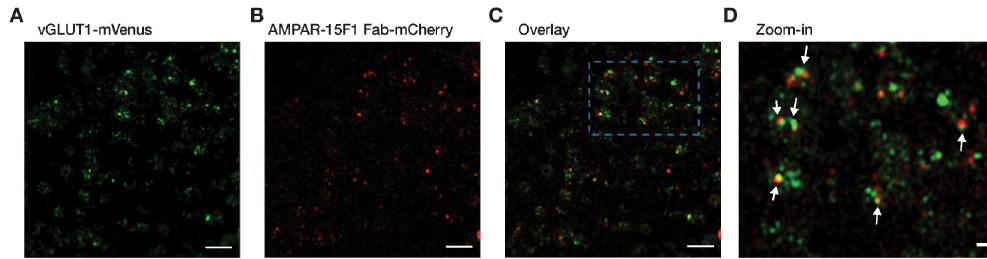
Fig 4. Cryo-LSM images of glutamatergic synaptosomes on cryo-EM grids passed through 1 μ m filter using a thermobarrel extruder. Fluorescence signals from green, red and both green & red channels corresponding to (A) vGLUT1-mVenus, (B) AMPAR-15F1 Fab-mCherry and (C) both vGLUT1-mVenus & AMPAR-15F1 Fab-mCherry. (D) Zoomed-in area enclosed in cyan dashed box in (C) with glutamatergic synaptosomes highlighted with white arrows. Scale bar in (A-C): 5 μ m and scale bar in (D): 2 μ